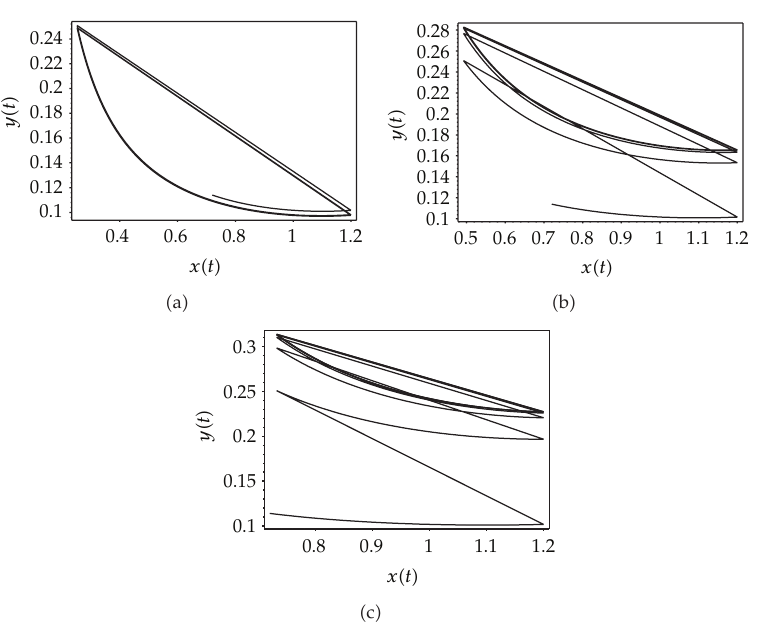
Figure 12: The phase portraits of system (cid:6) 1.3 (cid:7) with x 0 (cid:8) 0 . 72, y 0 (cid:8) 0 . 114, q (cid:8) 0 . 5, ι (cid:8) 0 . 2, and di ff erent p : (cid:6) a (cid:7) p (cid:8) 0 . 79; (cid:6) b (cid:7) p (cid:8) 0 . 59; (cid:6) c (cid:7) p (cid:8) 0 . 39.